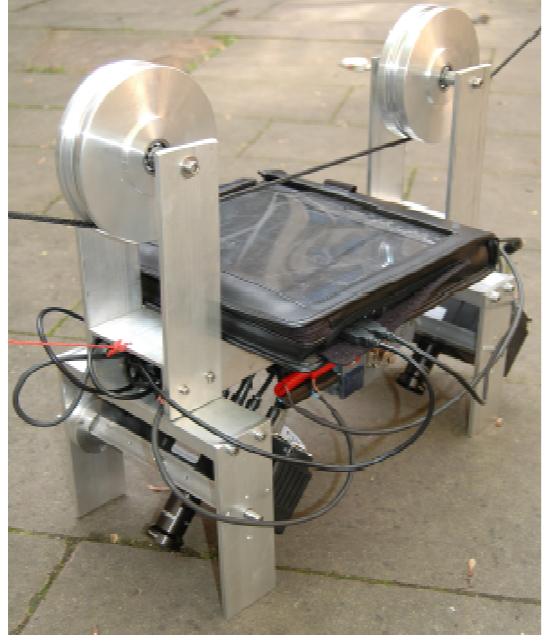
Figure 4. Experimental device ready for